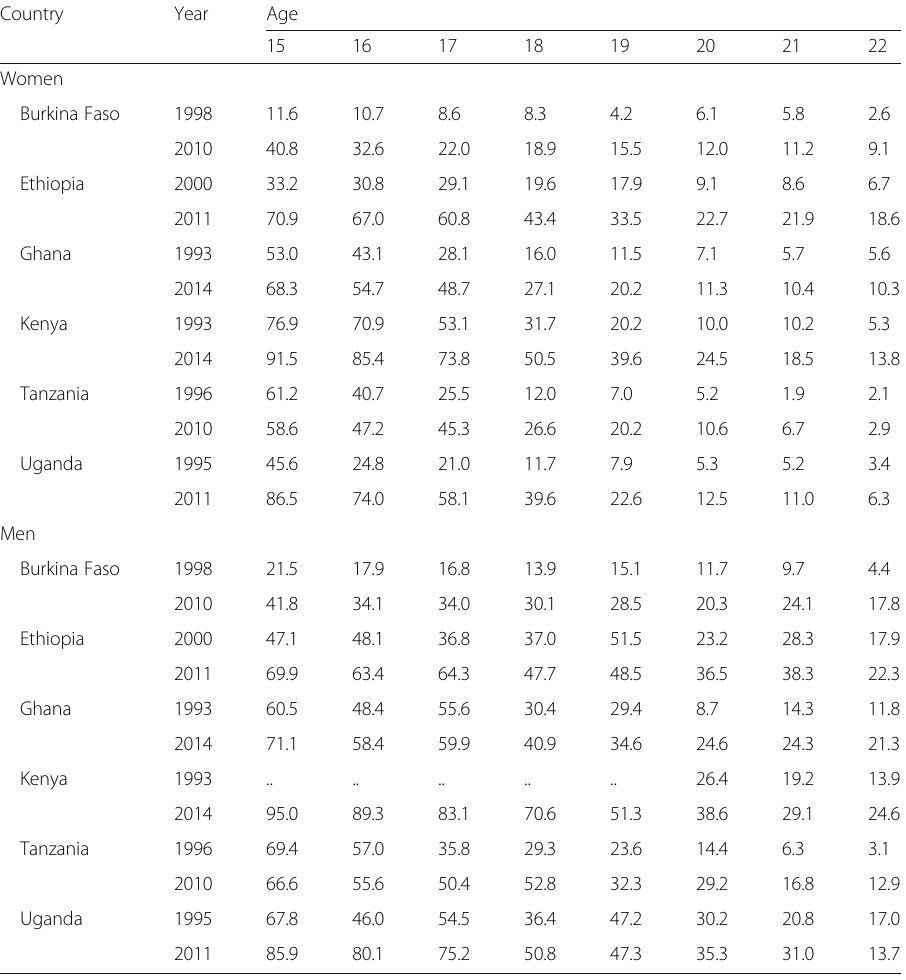
Table 1 Percentage of young women in education, by current age Country Year Age Women